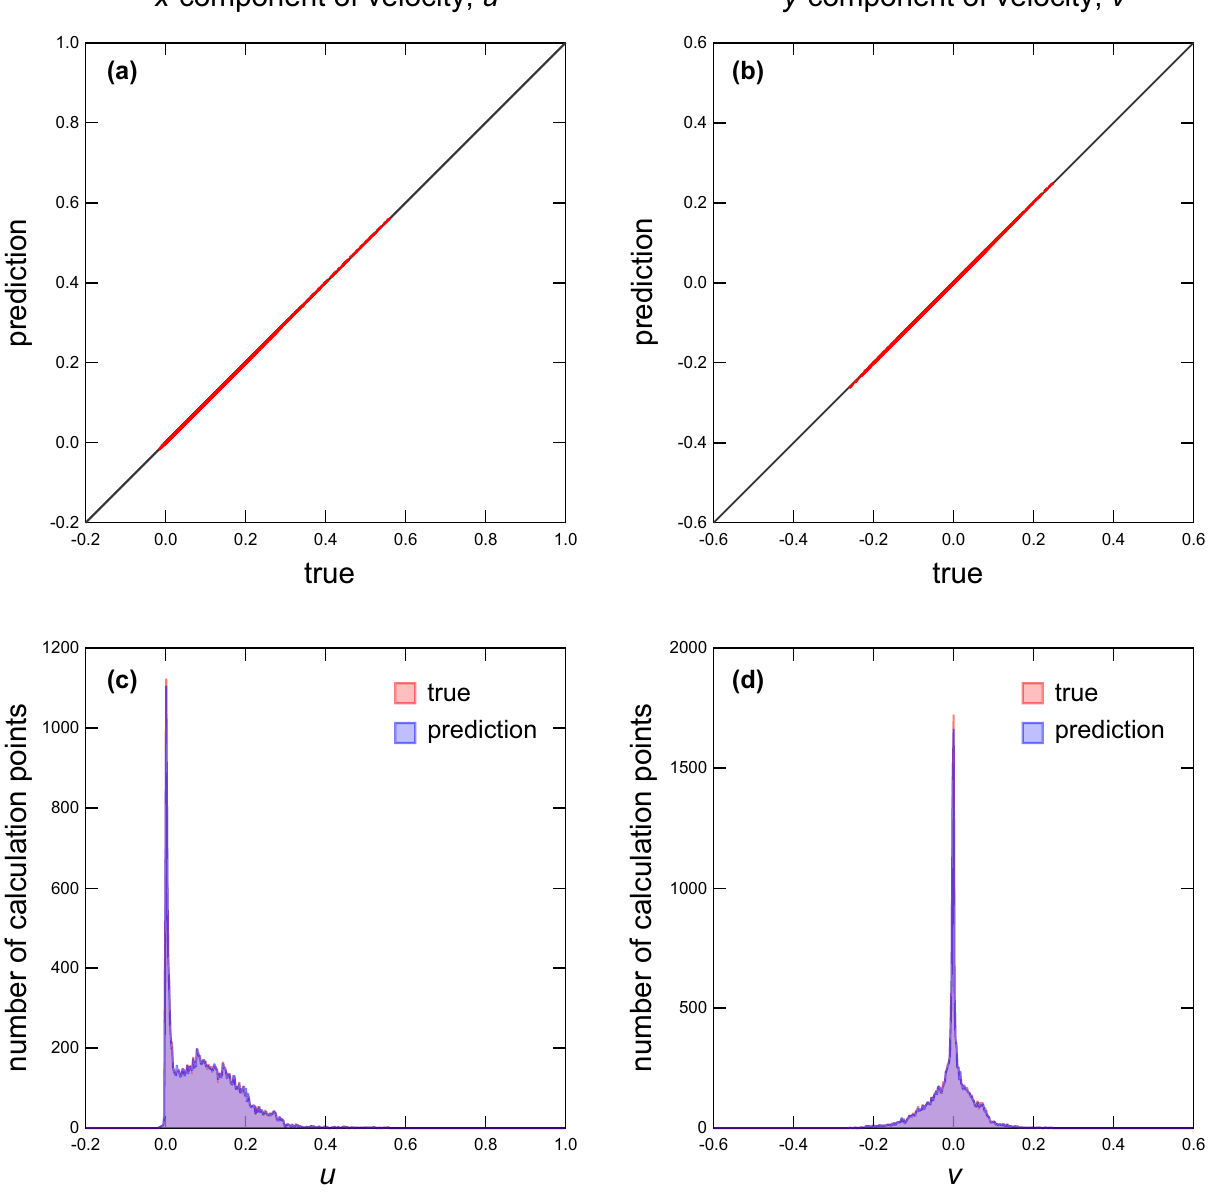
Figure 5. Scatter plots ( a , b ) and histograms (c and d) of the true and predicted flow velocities of all calculation 48 . ( a ) Scatter plot of true and predicted x -components of the points. The number of cylinders is set at N = flow velocity u . ( b ) Scatter plot of true and predicted y -components of the flow velocity v . ( c ) Histograms of true (red) and predicted (blue) x -components of the flow velocity u . (d) Histograms of true (red) and predicted (blue) y -components of the flow velocity v